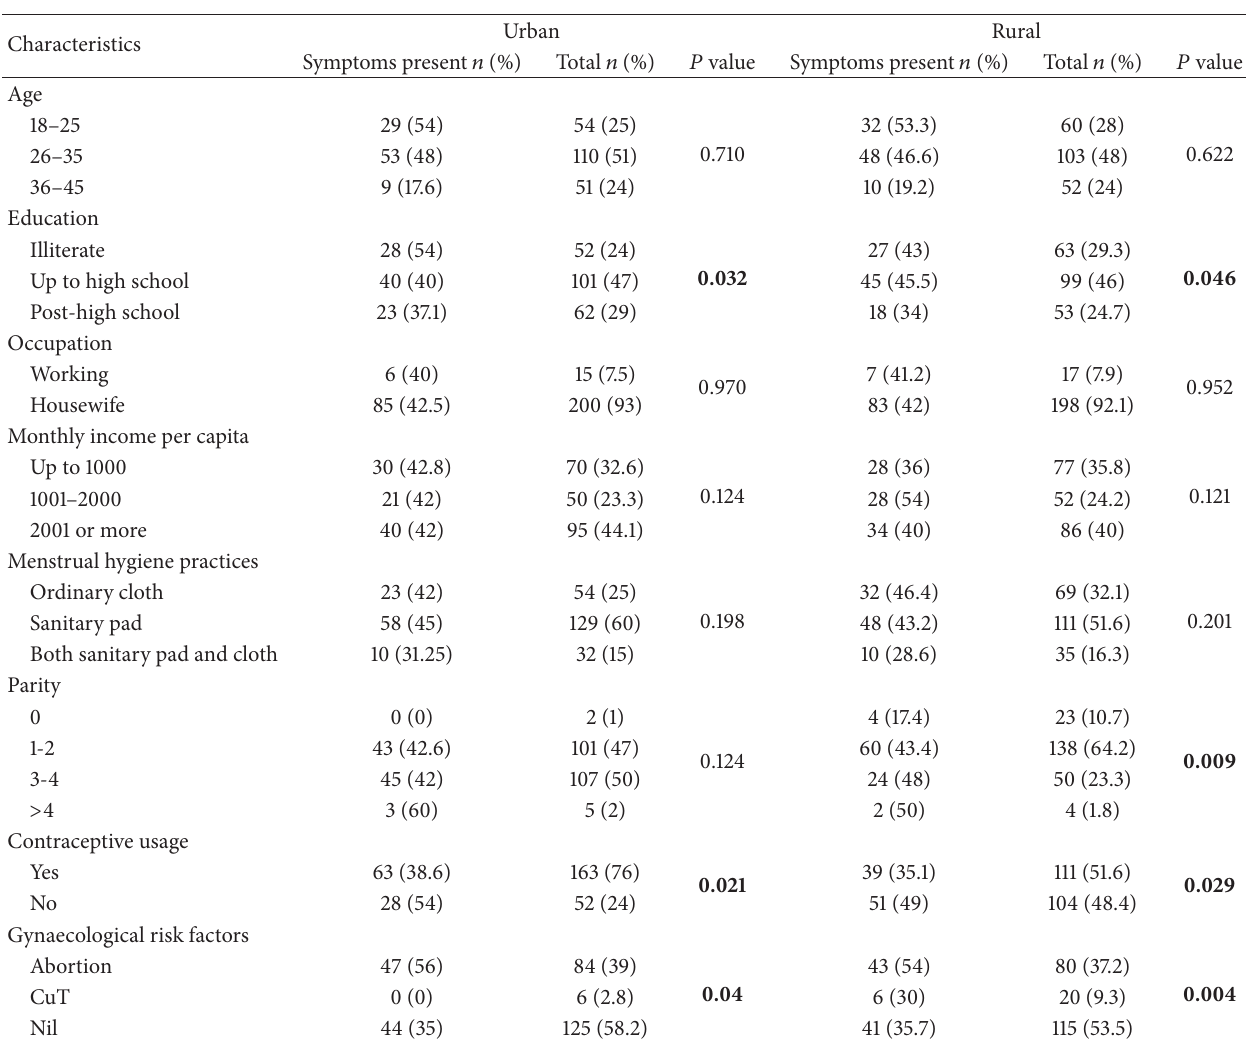
Table 5: Prevalence of symptoms suggestive of RTI/STI in relation to sociodemographic, obstetric, and behavioural factors in urban and rural